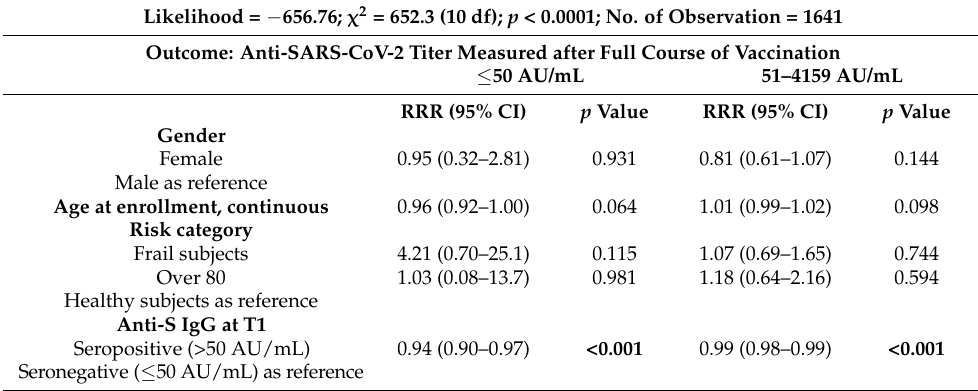
Figure 1. Percentage of seroconversion (anti-S IgG ≥ 50 AU/mL) 30 days after the conclusion of full course of BTN162b2 vaccination, by age and sex. Table 2. Results of the multinomial regression analysis estimating predictors of the anti-SARS-CoV-2 titer measured after full course of